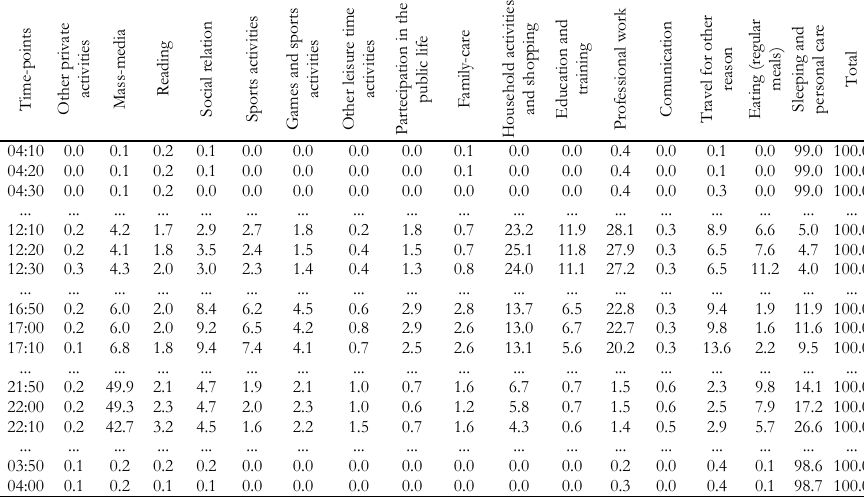
Percentage of total population (or social sub-groups) engaged in all daily activities collapsed in 16 subgroups at fixed time-points for the 24 hours (weekdays, Saturday, Sunday) being at given – Contingency matrix N 144;16 s t n t v a po i p r i - r m e h e T i O t